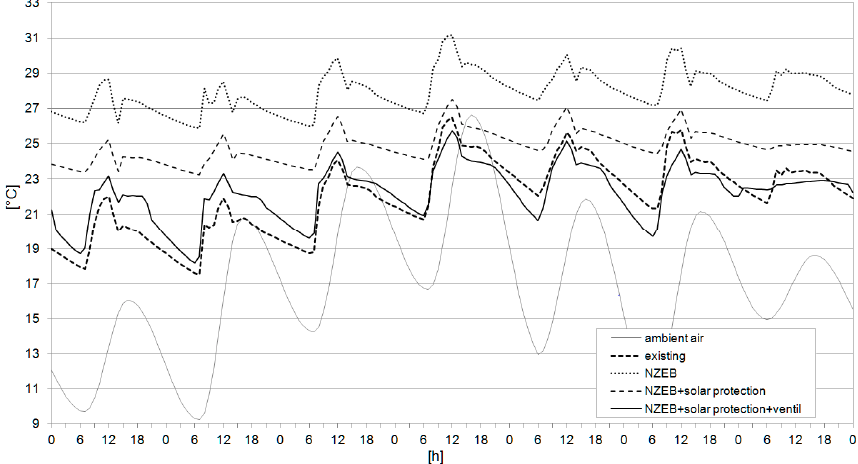
Figure 2. Operative temperature evolution in an east-oriented classroom in Rome—1 to 7 May. The impact of solar gains through the roof on the thermal comfort was assessed ana- lyzing the operative temperature differences calculated at the top floor and at the inter- mediate level. The frequency distribution plot of Figure 3 presents the exemplary case of the south-oriented classroom in Milan. The operative difference is lower than 0.5 and 0.8 °C in more than 50% and 90% of the observation period, respectively. Similar results were achieved for other building configurations; thus, they are not presented here for brevity. This result shows that temperature differences among floors were often negligible. For such reasons, further elaboration on the operative temperature is presented for the class- room at the intermediate floor, as representative of all the classrooms with the same ori- entation. The role of the roof, as a source of heat in classrooms, is reintroduced again for the discomfort analysis. Figure 3. Frequency distribution of operative temperature differences between south- oriented classrooms at intermediate and upper floors in Milan.